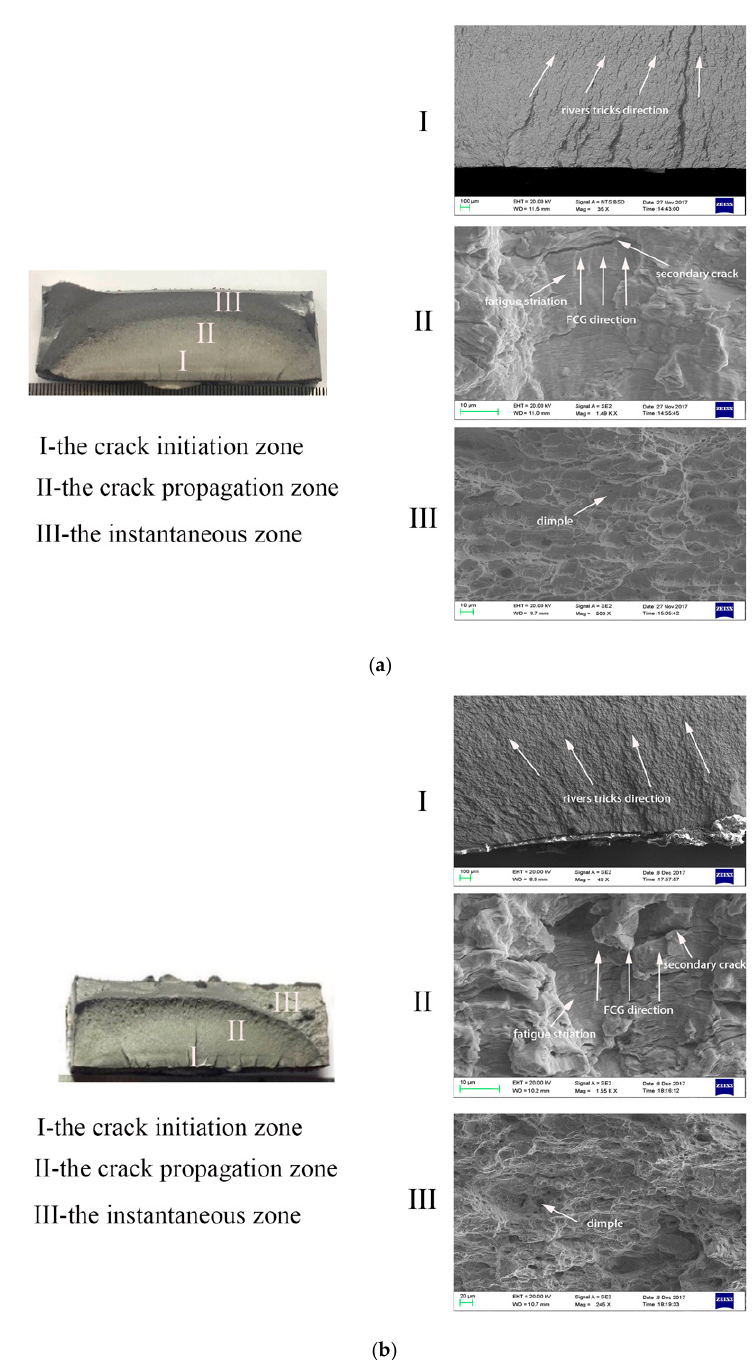
Figure 15. The fractography of two welded joints: ( a ) the fractography of T-welded joints and ( b ) the fractography of cruciform welded joints.